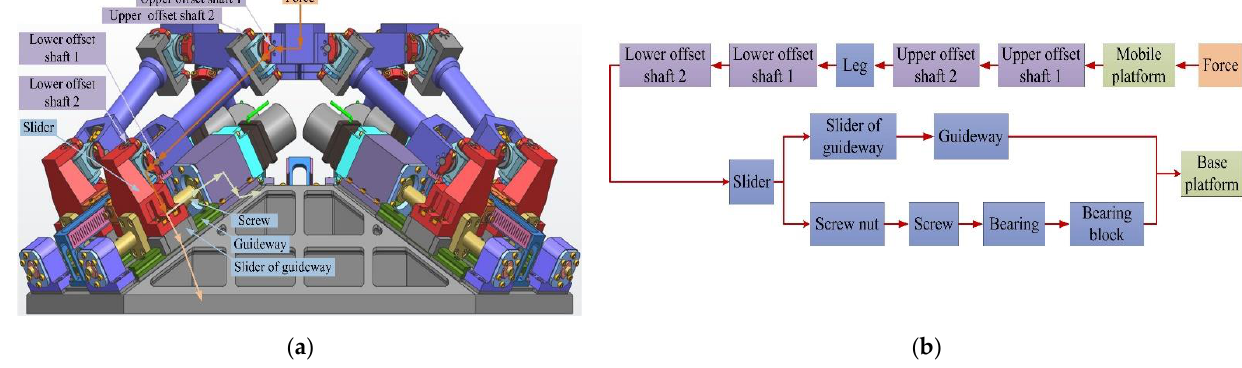
Figure 4. Force transfer analysis: ( a ) Transfer chain of force; ( b ) Block diagram of force transfer process.